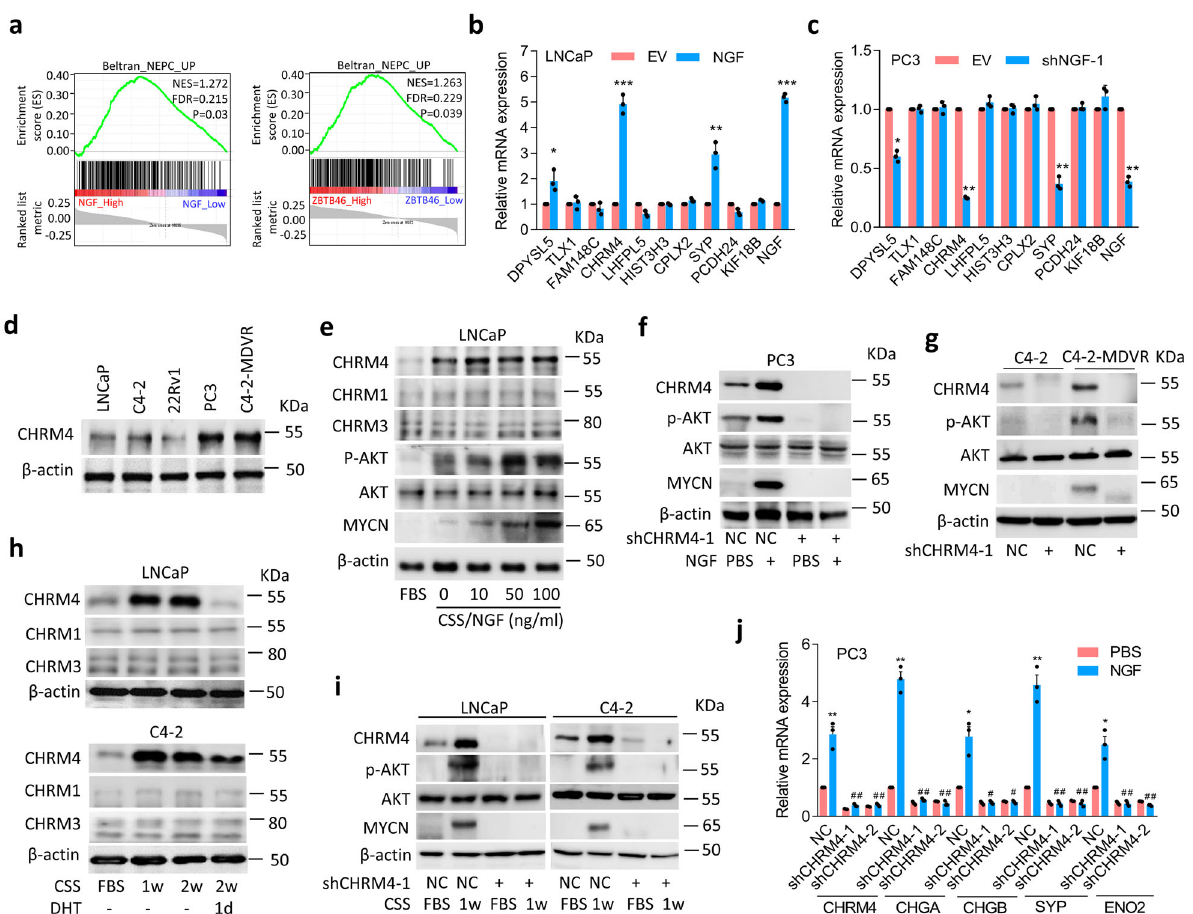
Fig. 5 CHRM4 activates AKT and MYCN signaling and promotes neuroendocrine differentiation of prostate cancer. a GSEAs of TCGA prostate cancer dataset showed that higher expression levels of both the NGF and ZBTB46 in prostate cancer tissues were positively associated with a NEPC-responsive gene signature 25 . NES normalized enrichment score, FDR false discovery rate. b , c Relative mRNA levels of the top 10 candidate genes from Supplementary Table 6 in LNCaP cells with an empty vector (EV) or NGF cDNA vector overexpression ( b ) or in PC3 cells with non-target control (NC) or NGF shRNA vector expressions ( c ). d Western blotting of CHRM4 in various prostate cancer cell lines. e Western blotting of CHRM4, CHRM1, CHRM3, p-AKT, AKT, and MYCN in LNCaP cells treated with various concentrations of the NGF protein in charcoal-stripped serum (CSS)-containing medium for 1 week. Fetal bovine serum (FBS)-containing medium without the NGF protein served as a control. f Western blotting of CHRM4, p-AKT, AKT, and MYCN in PC3 cells stably transfected with the NC or CHRM4 shRNA vector, and cells were treated with 100 ng/ml NGF protein in CSS-containing medium for 1 week. g CHRM4, p-AKT, AKT, and MYCN protein levels in C4-2 and C4-2-MDVR cells following stable CHRM4-knockdown. h CHRM4, CHRM1, and CHRM3 protein levels in LNCaP and C4-2 cells cultured in CSS-containing medium for 1 and 2 weeks, followed by treatment with 10 nM dihydrotestosterone (DHT) for 1 day. i Protein levels of CHRM4, p-AKT, AKT, and MYCN in LNCaP and C4-2 cells following stable CHRM4-knockdown and cultured in CSS-containing medium for 1 week. j Relative mRNA levels of CHRM4, CHGA, CHGB, SYP, and ENO2 in PC3 cells following stable expression of NC or CHRM4 shRNA vector and treated cells with 100 ng/ml NGF protein in CSS-containing medium for 1 week. * vs. Phosphate buffered saline (PBS); # vs. the NC. Data from the quanti fi cation of mRNA are presented as the mean ± SEM of three independent experiments; n = 3 per group. * p < 0.05, ** p < 0.01, *** p < 0.001; by a two-way